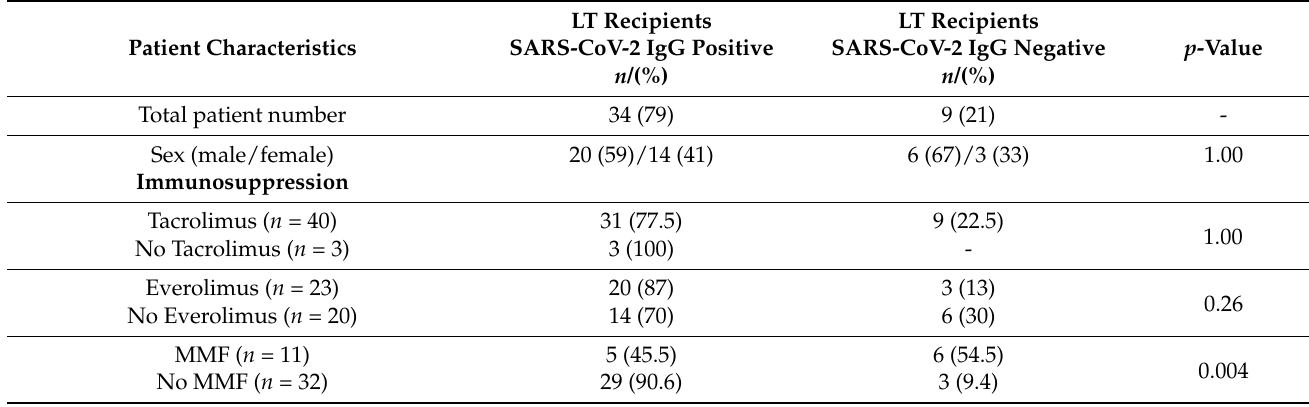
Table 4. Comparison of the LT recipients with negative and positive SARS-CoV-2 serology after vaccination. Patient characteristics are presented as absolute number n and percentage or median and interquartile range. Patient